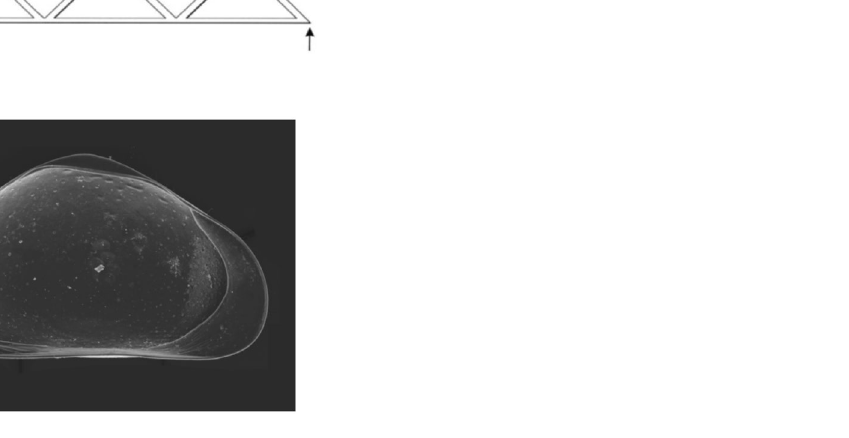
Figure 6. ( A ) Architectural representation of the triangular shape of ostracod carapace. ( B ) Female left valve in lateral view of Pseudocandona movilaensis sp.